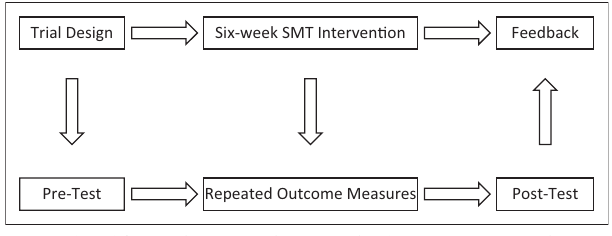
FIGURE 2: Scheme for the research design followed.